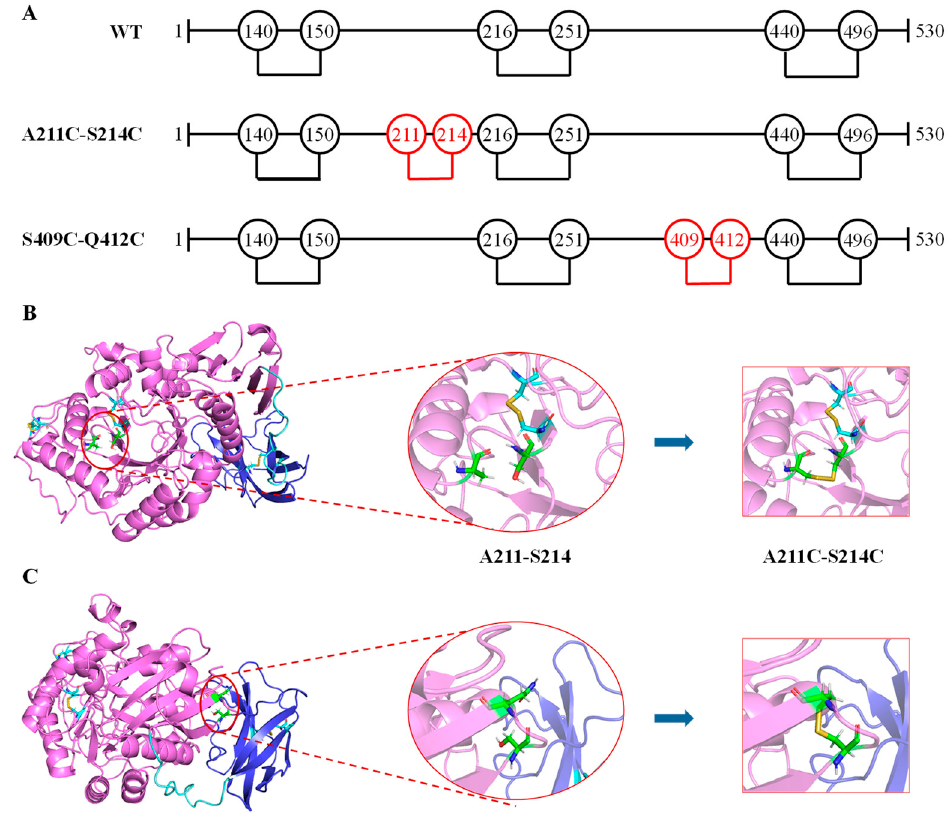
Figure 2. Disulfide bonds in MFA ps . ( A ) Diagram of MFA ps amino acid sequence indicating native cysteine residues (black) and new mutated residues (red) forming disulfide bonds. ( B ) Structure of variant A211C-S214C. ( C ) Structure of variant S409C-Q412C. Native and new cysteines residues are represented by cyan and green sticks, respectively.